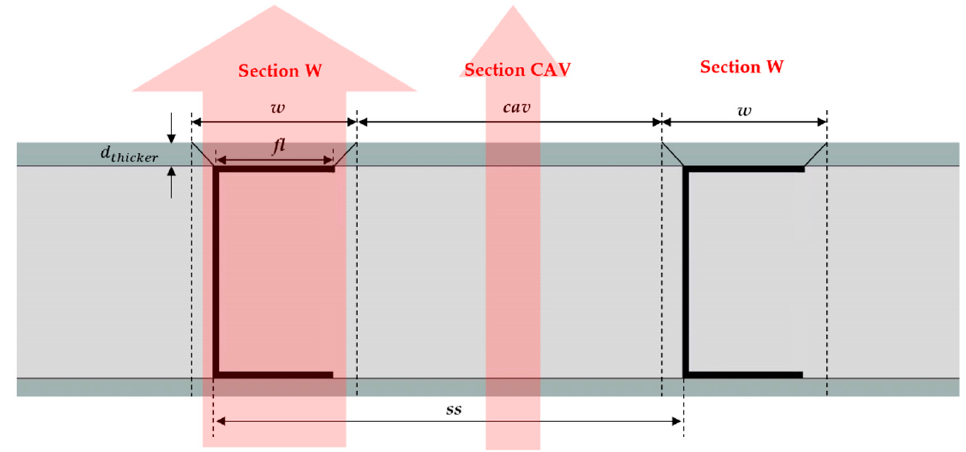
Figure 7. Section W and Section CAV in the ASHRAE Zone method.